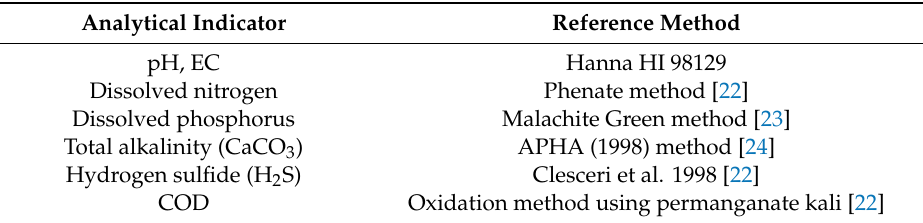
Table 3. The methods of analysis of indicators in